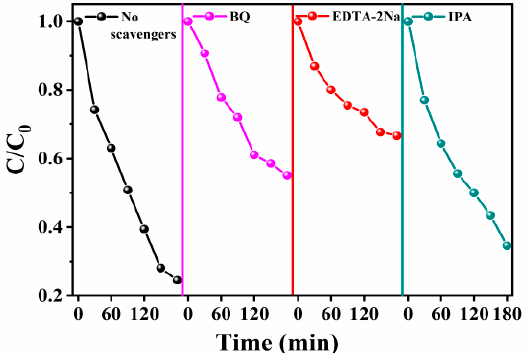
Figure 11. The capture experiments of 1% CIS/BOC-SOVs under visible light.